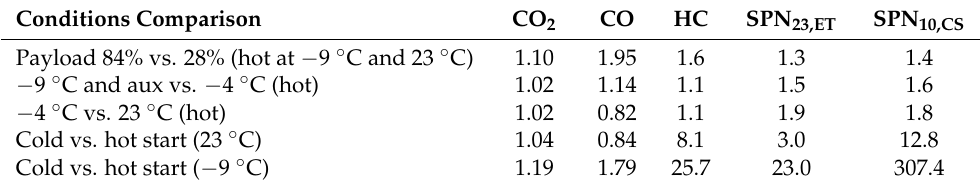
Table 2. Pollutants ratios for various